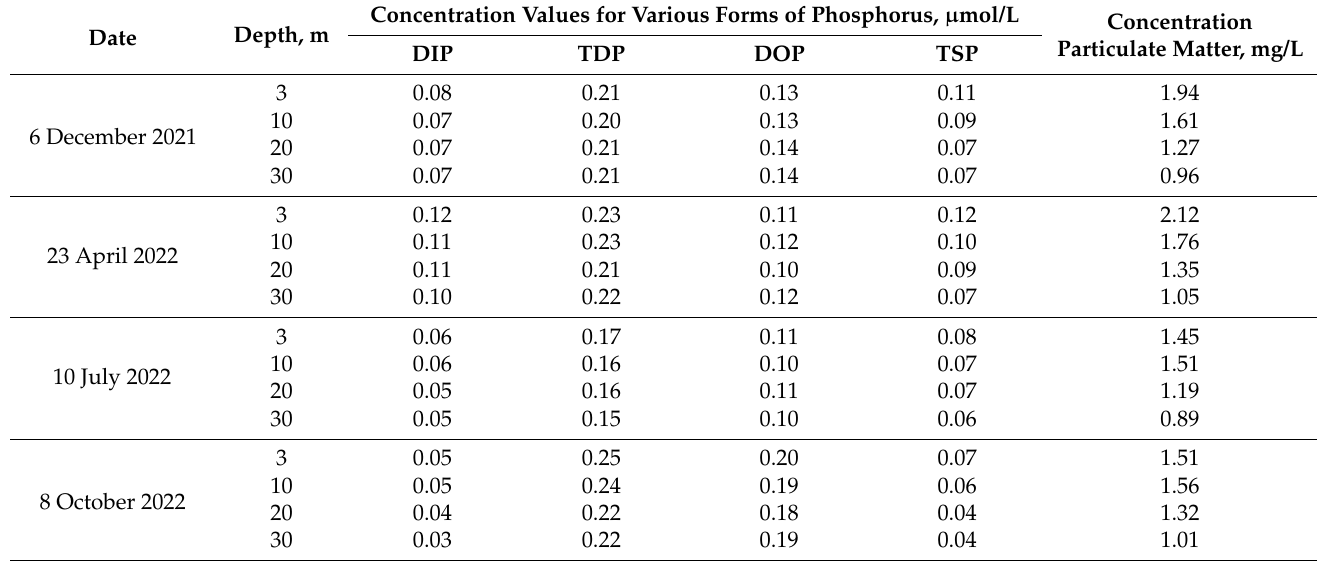
Table 1. Concentration values for different forms of phosphorus in different seasons.